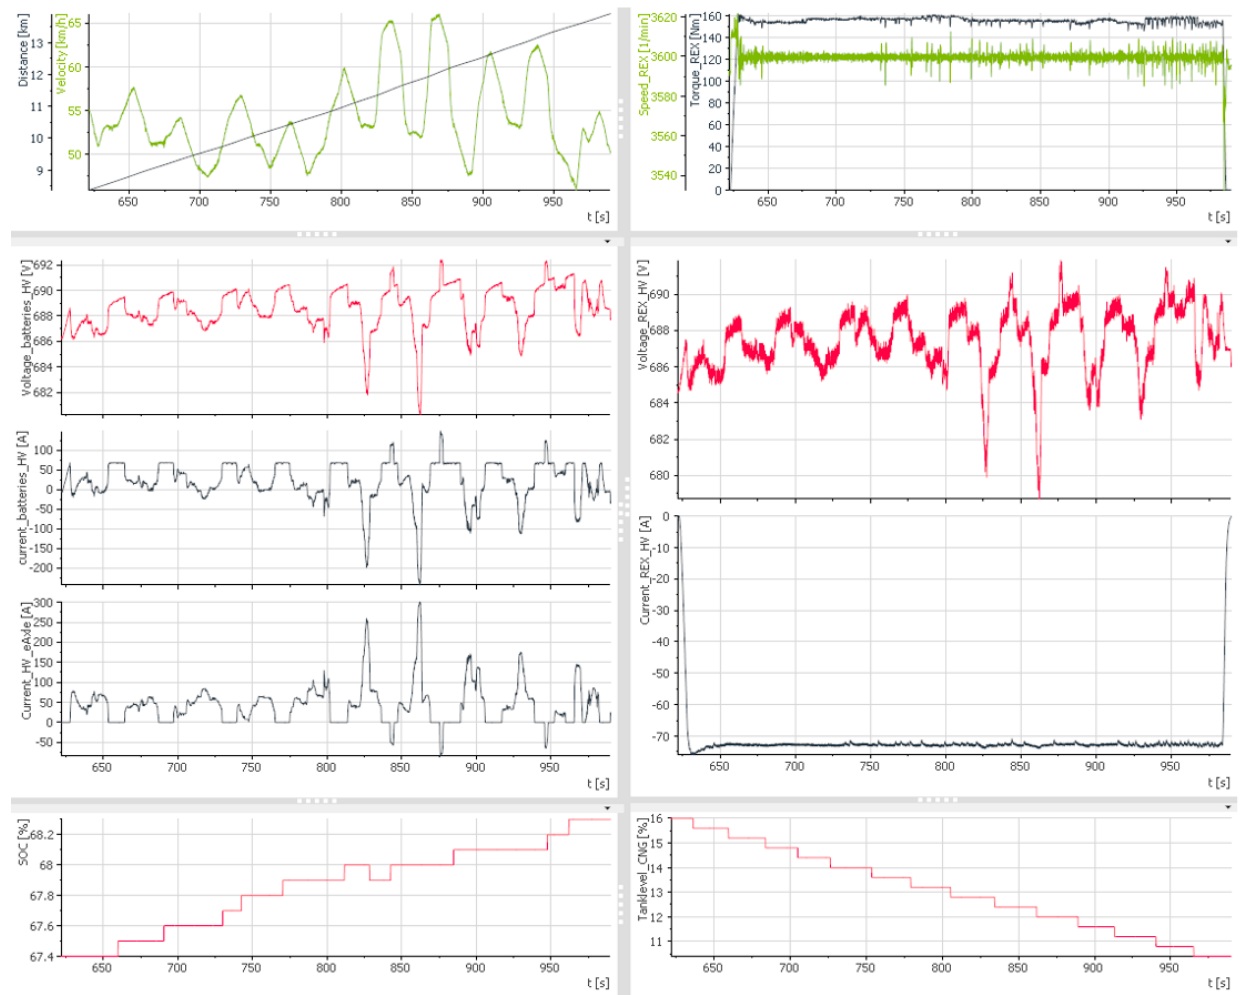
Figure 7. Vehicle operation in REx mode.